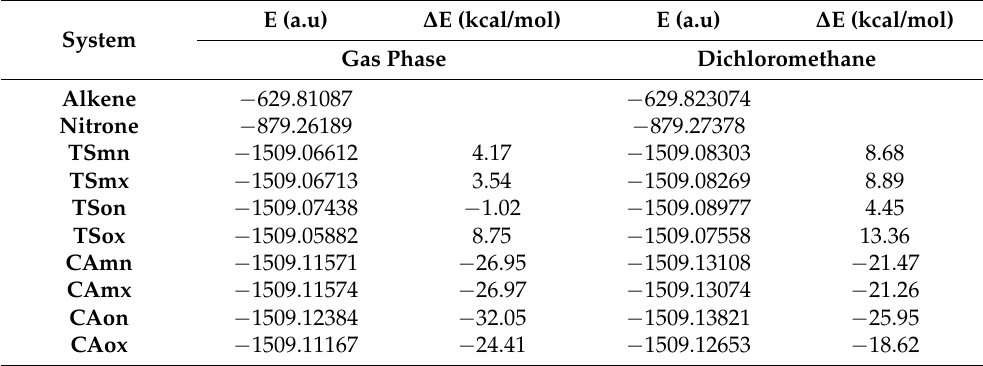
Table 2. Values of total and relative energy in gas phase and in dichloromethane solution of stationery points of the32CA reaction between nitrone 1 and ethylene 2